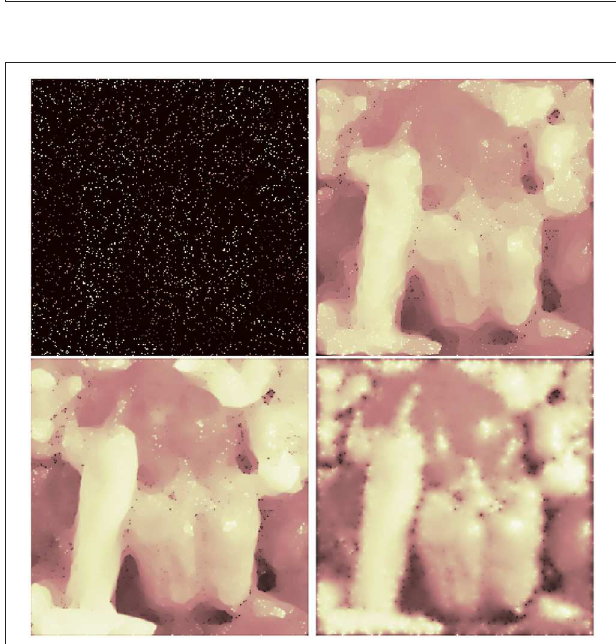
FIGURE 13 | Inpainting for 95% missing pixels: damaged image (top, left), standard TV inpainting (top, right) and spline inpainting of order 3 with TV norm (bottom, left), and squared TV norm (bottom, right).